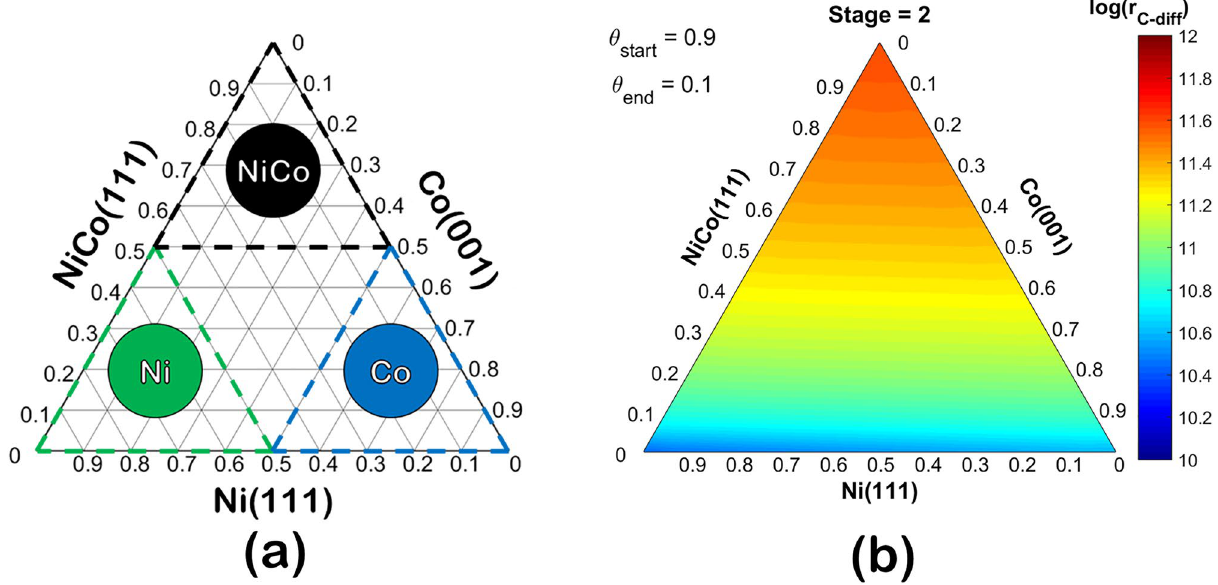
Figure 14. Ternary contour plot (TCP) exhibiting ( a ) three zones of dominant 111-analogous surface in the NiCo bimetallic catalyst: Ni111-dominant, Co111-dominant, and NiCo111-dominant, and ( b ) the rate of surface carbon diffusion (log(r C-diff )) as a function of the Ni111:Co111:NiCo111 surface fraction at a specified initial site surface carbon coverage (θ start ), terminal site surface carbon coverage (θ end ), where the low to high log rate is from the color of blue to red in the colored